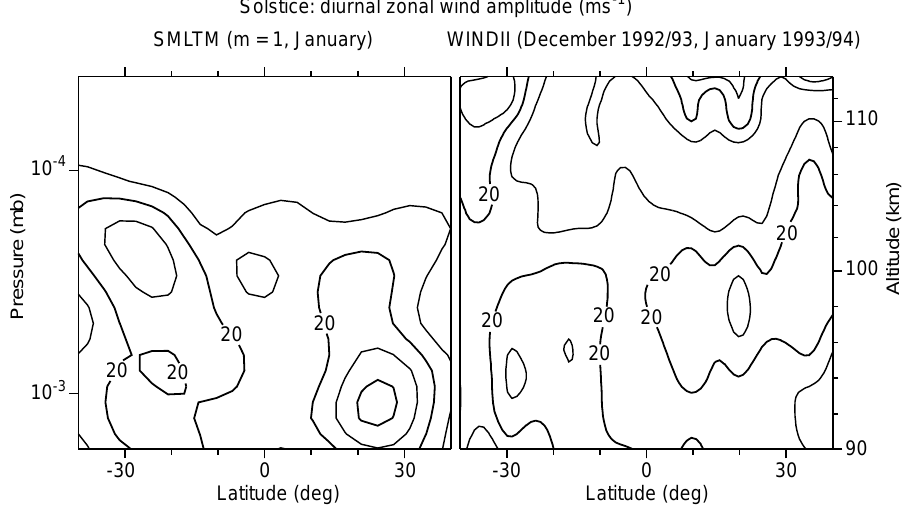
Fig. 5. Same as in Fig. 4 but for the